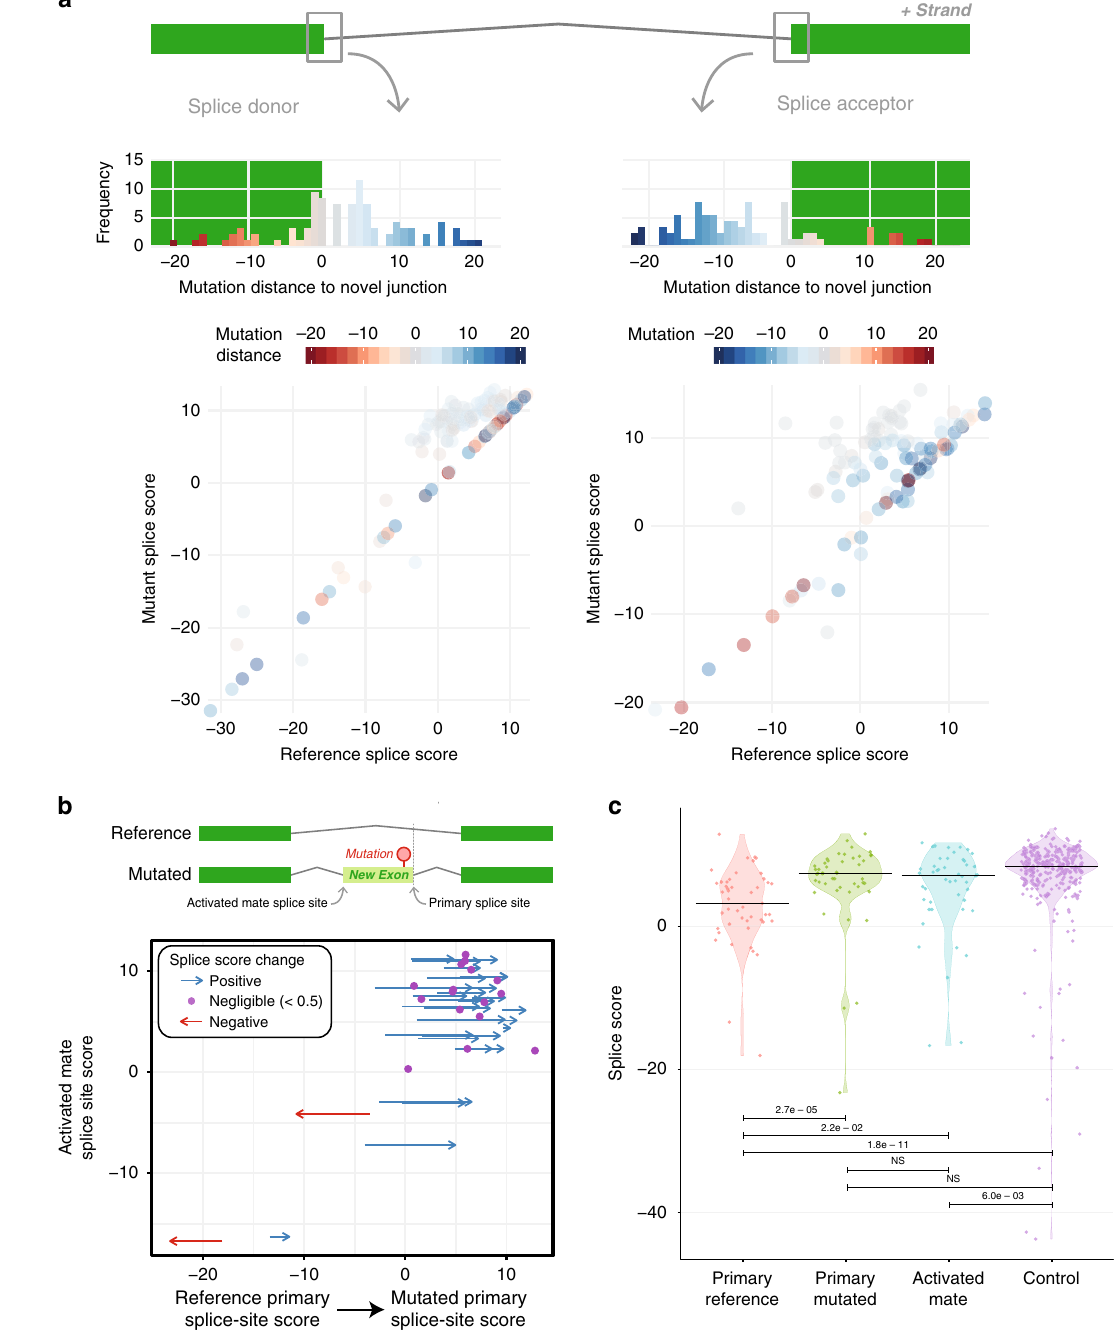
Fig. 3 Characterization of nc-SCMs from TCGA WGS data. a Frequency distribution of the distance from mutations to splice sites and splicing score comparison between the reference and mutant primary splice sites for donors and acceptors. Blue and red colors represent introns and exons, respectively. b Splice score distribution of new exon splice sites. Red arrows represent negative changes in score, blue arrows represent positive changes in score, and dots represent little to no changes in score (change <0.5). Arrow length is proportional to the magnitude of the change. c Comparison of primary splice score before and after mutation, the activated mate score in new exons, and the score of 300 random control sites. Source data are provided as a Source Data fi